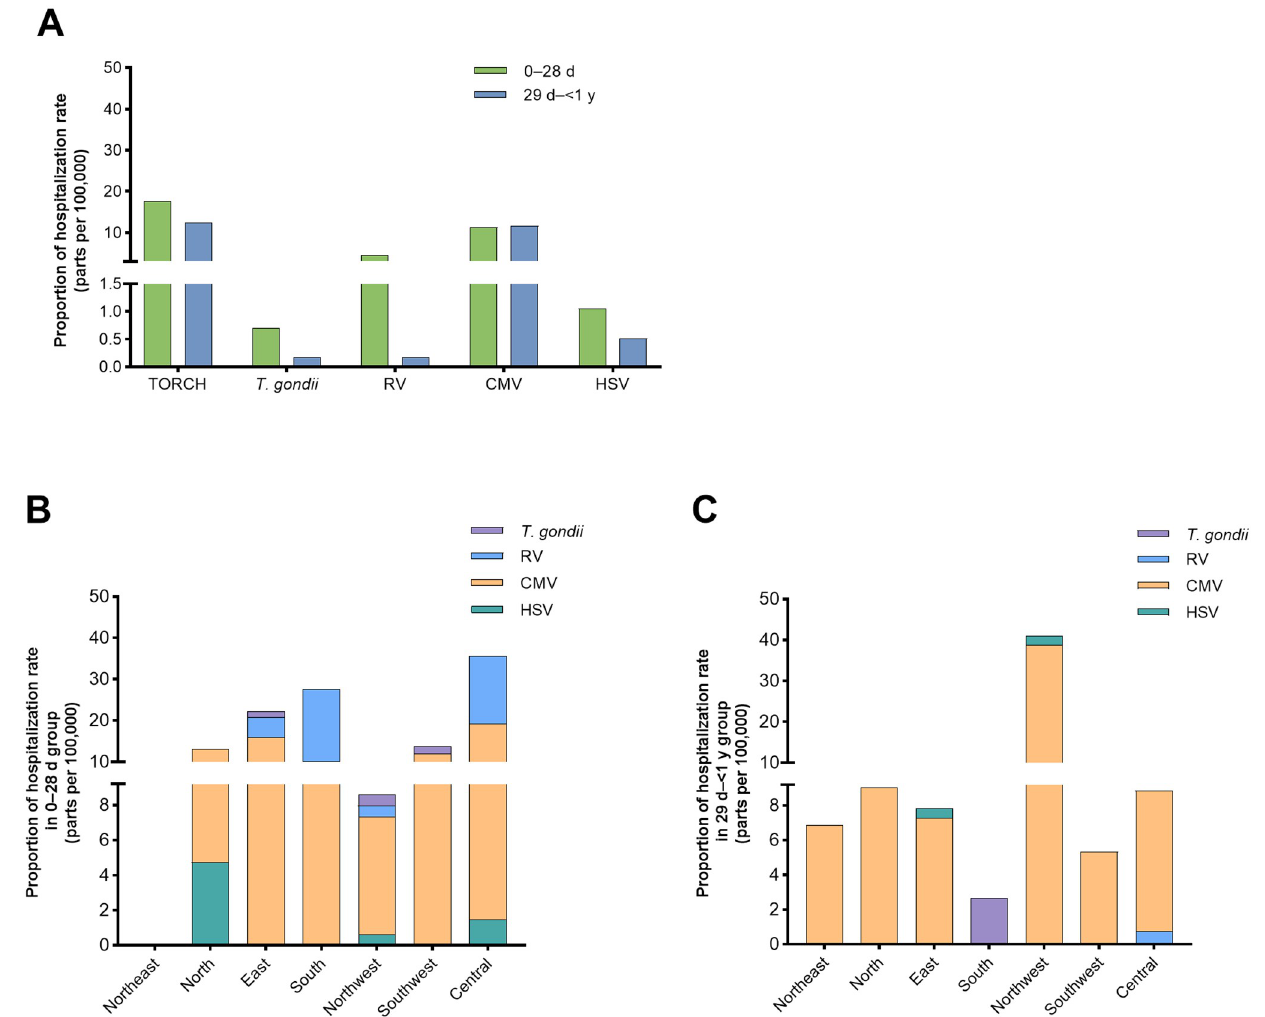
Fig 1. Proportion of patients hospitalized for congenital TORCH